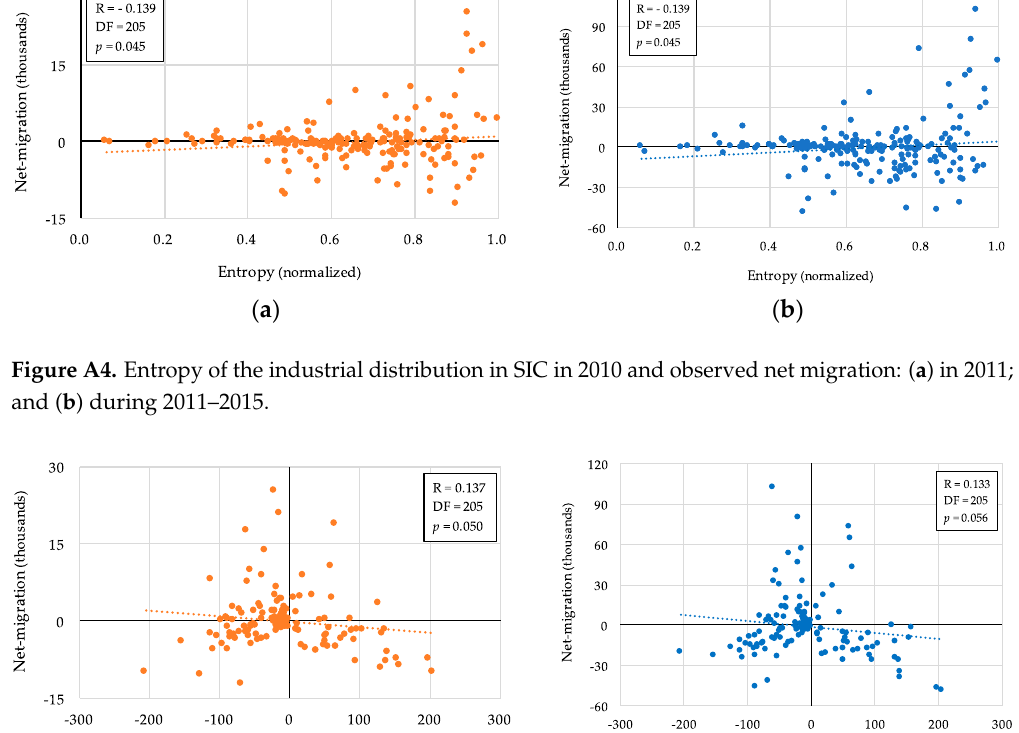
Figure A3. Employment rate in 2010 and observed net migration: ( a ) in 2011; and ( b ) during 2011–2015. ISPRS Int. J. Geo-Inf. 2017 , 6 , 352